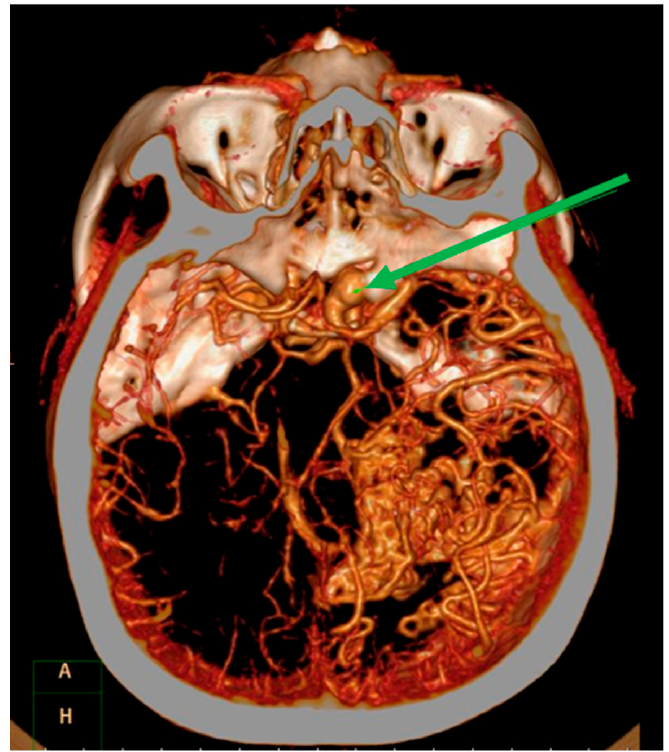
Figure 3. Computed tomography angiography. Imaging revealed focal heterogeneous enhancement with a surrounding multilinear contrast structure, and a lower density and calcified spots in the right temporal-parietal occipital lobe. The green arrow shows an ipsilateral supraclinoid internal carotid artery aneurysm.